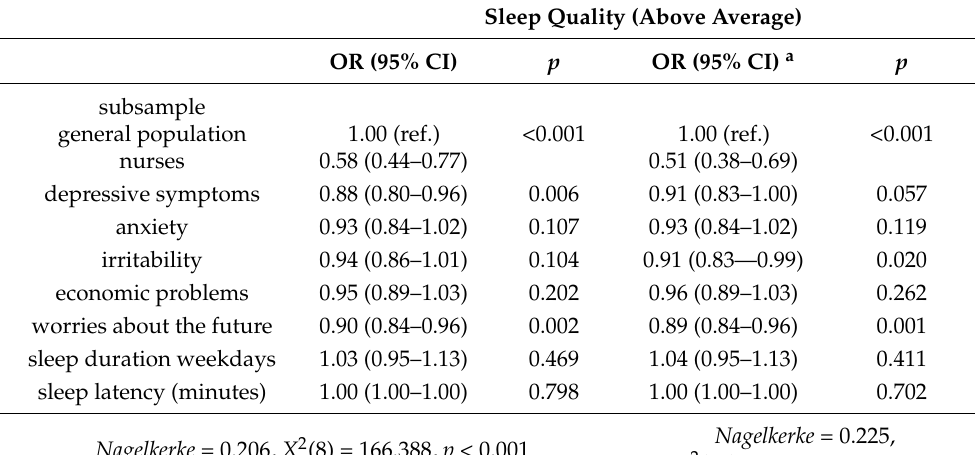
Table 4. Logistic regression of sleep